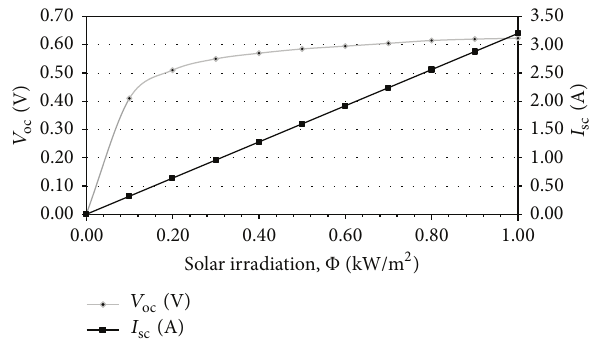
Figure 1: 𝑉 and 𝐼 variations as a result of changes in radiation. oc sc